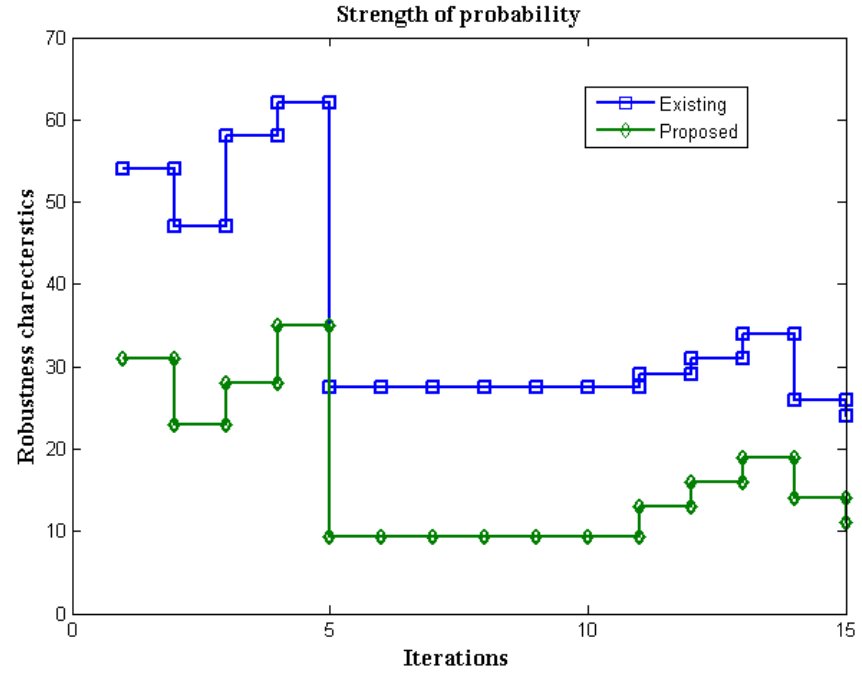
Figure 9. Robustness characteristics. Table 8. Strength of probabilistic algorithm.